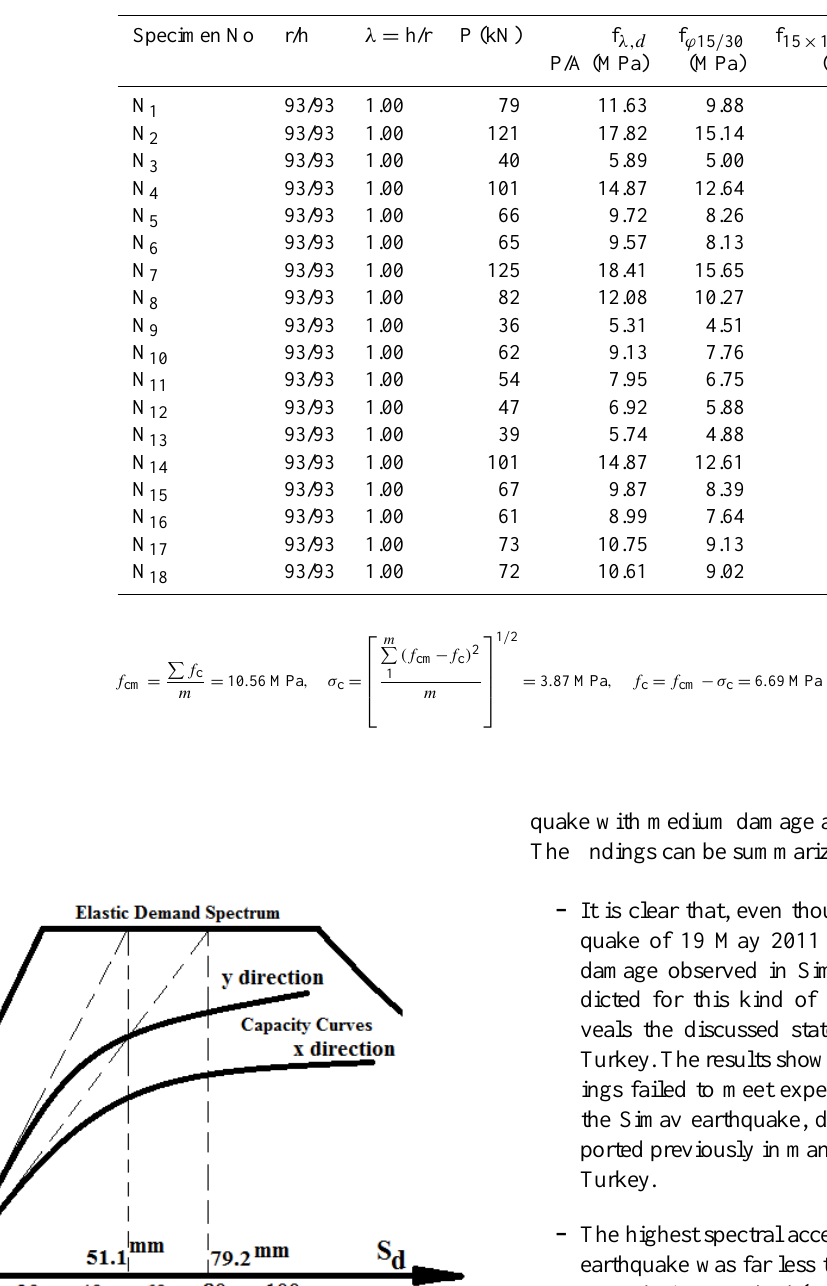
Table 6. Compressive test results of the concrete specimens – case study 2.